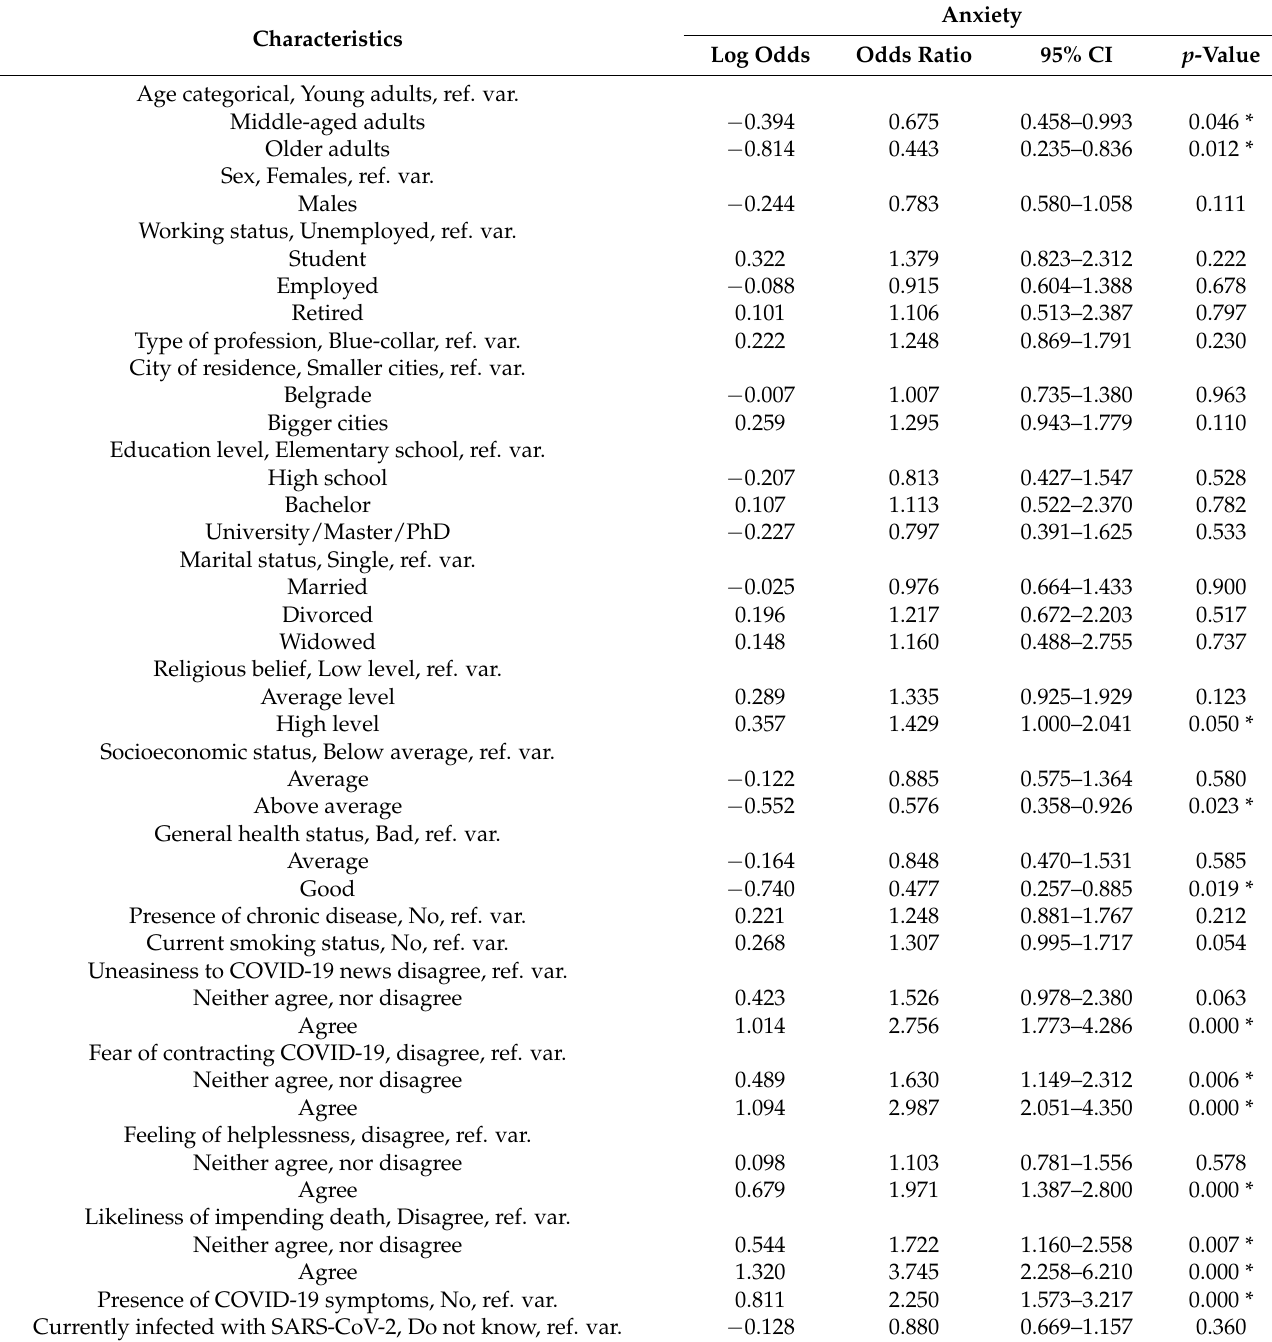
Table 5. Ordinal regression results for the anxiety